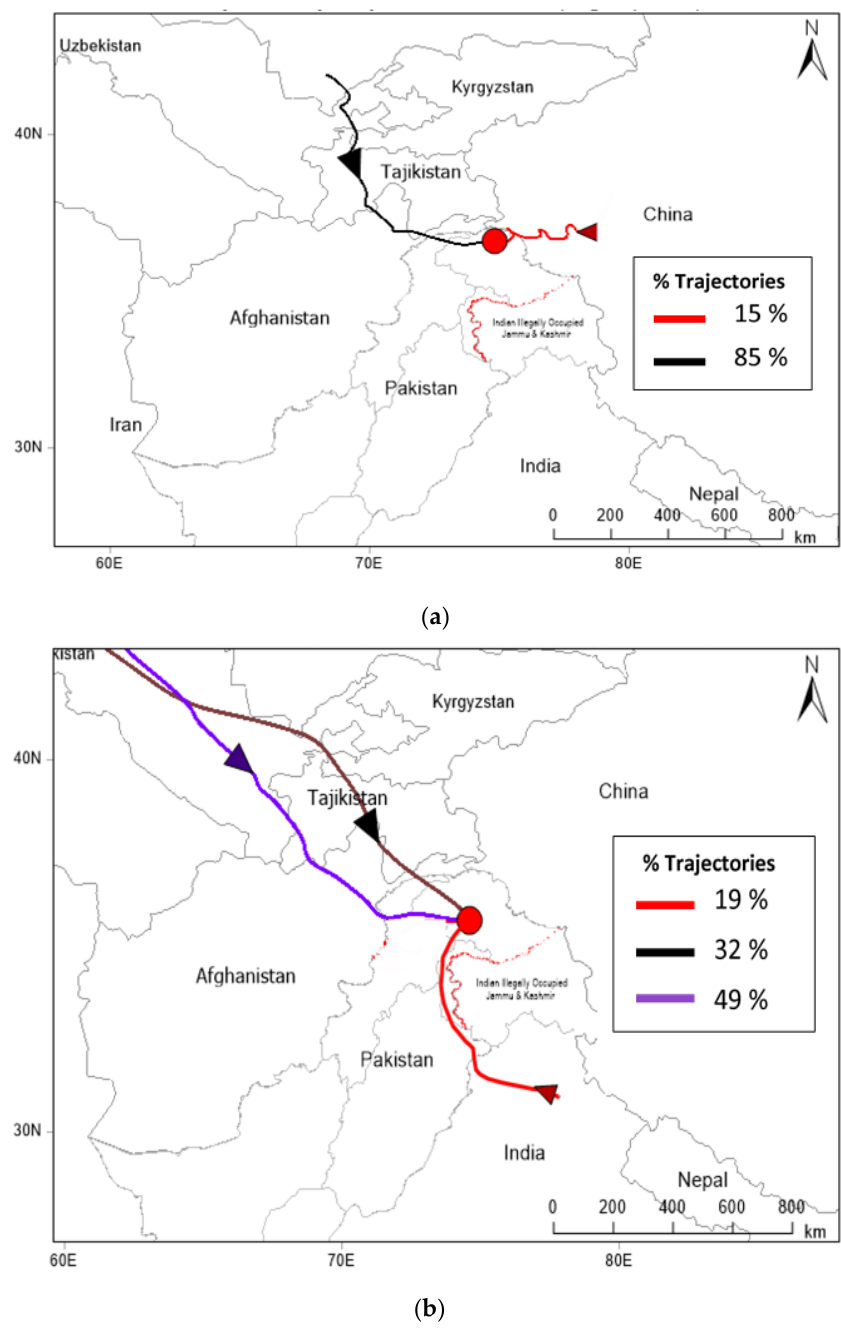
Figure 10. ( a ). Percentage of five-day back air trajectory clusters reached over Sost during summer, 2020. ( b ). Average percentage of five-day back air trajectory clusters reached over Hunza, Gilgit, Jaglot and Chilas during summer, 2020.